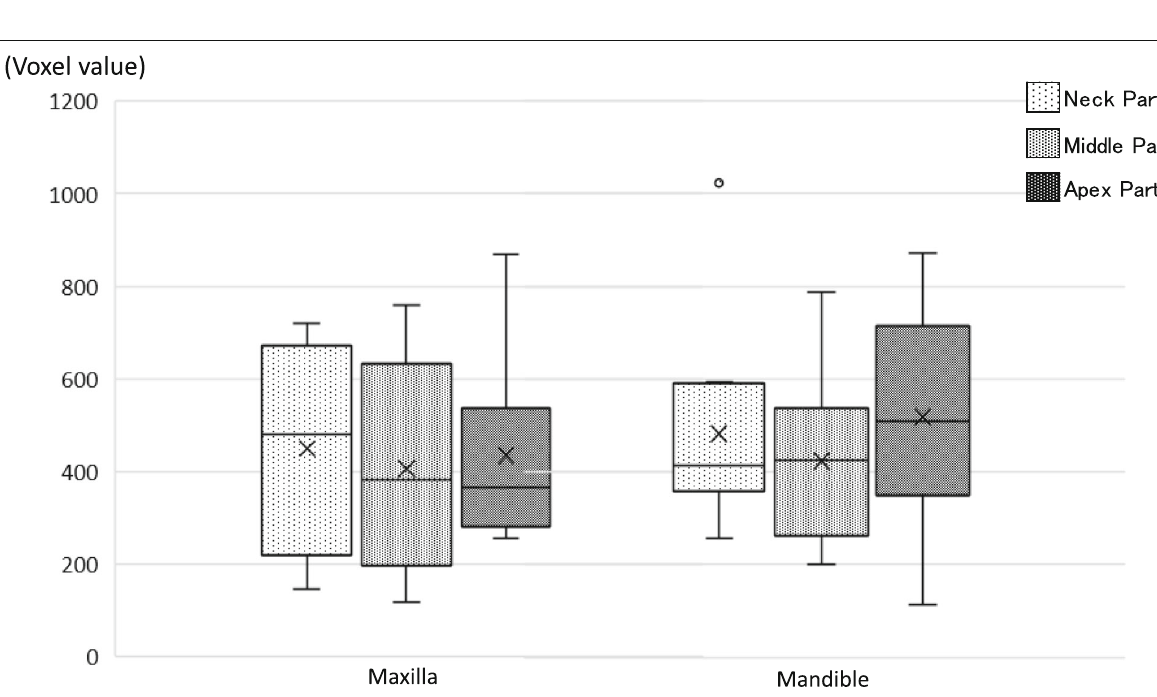
Fig. 7 The average voxel value between the maxilla and mandible. There was no difference between the maxilla (430.9±211.6) and the mandible (475.6±211.5) in the average voxel value. Also, no difference was found in each